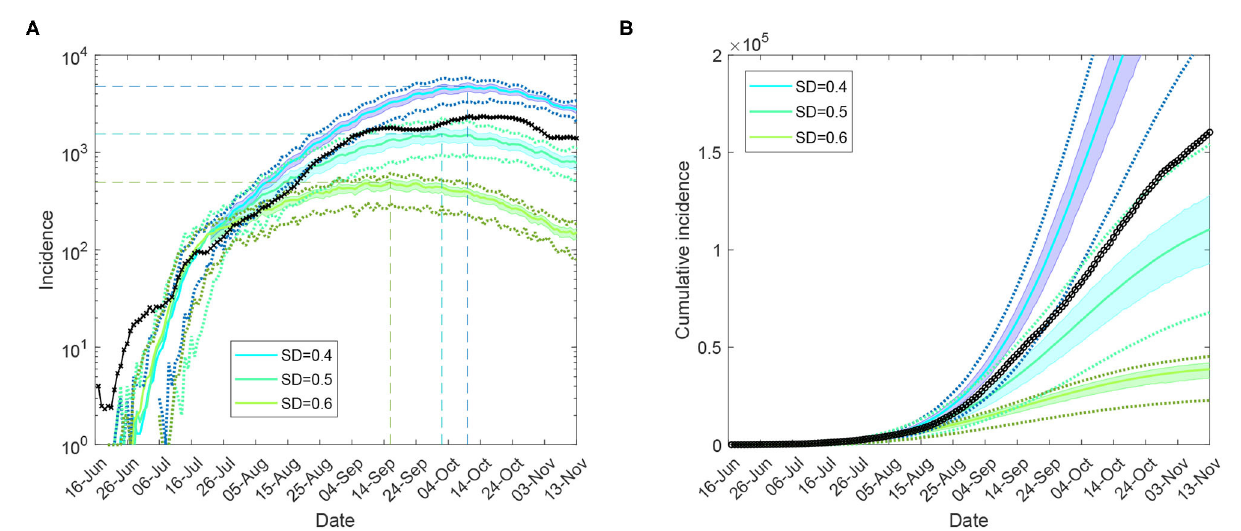
FIGURE 3 | Moderate restrictions (Australia; progressive vaccination rollout; suppression threshold: 400 cases): a comparison between simulation scenarios and actual epidemic curves up to November 13, under moderate interaction strengths ( CI c = CI w = 0.25, HQ c = HQ w = 0.25, SD c = 0.25, SC = 0.5). A moving average of the actual time series for (A) (log scale) incidence (crosses), and (B) cumulative incidence (circles). Traces corresponding to social distancing levels SD ∈ { 0.4,0.5,0.6 } are shown for the period between 16 June and 13 November, as averages over 10 runs (colored profiles). 95% confidence intervals are shown as shaded areas. For each SD level, minimal and maximal traces, per time point, are shown with dotted lines. Peaks formed during the suppression period for each SD profile are identified with coloured dashed lines. Each SD intervention, coupled with school closures, begins with the start of initial restrictions. The alignment between simulated days and actual dates may slightly differ across separate runs. Case isolation and home quarantine are in place from the outset.